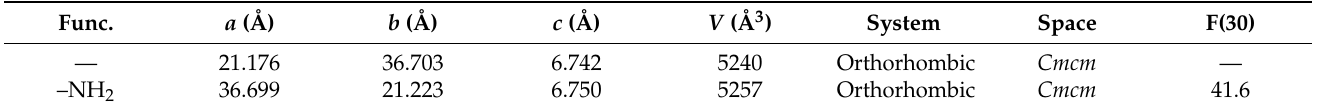
Table 1. Unit-cell dimensions of MIL-68(Ga) [34] and MIL-68(Ga)_NH 2 . The inset is the structure of